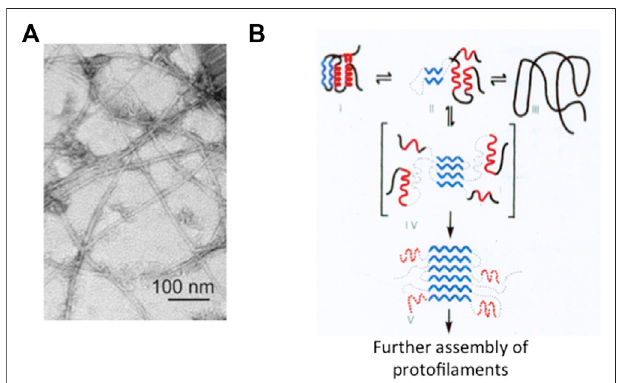
FIGURE 1 | Protein aggregation and misfolding. Panel (A) Electron microscopyimageoftheamyloidstateofA β ,adaptedfromLuetal.(2013).As discussed in the text, it appears that in spite of differences in the amino acid sequences or in the structure of the protein involved, the typical amyloid state consists of thread-like fi brils ofabout 10 nm diameter and rich in β -sheet structure.Panel (B) Schematicrepresentation ofthefoldingofasmallglobular proteinandtheformationofamyloid.Thenativestate(depicted onthetopleft) consists of two α -helices (in red) and two β -strands (in blue). Aggregation and formation of the amyloid is triggered by the accumulation of a misfolded intermediate (in square